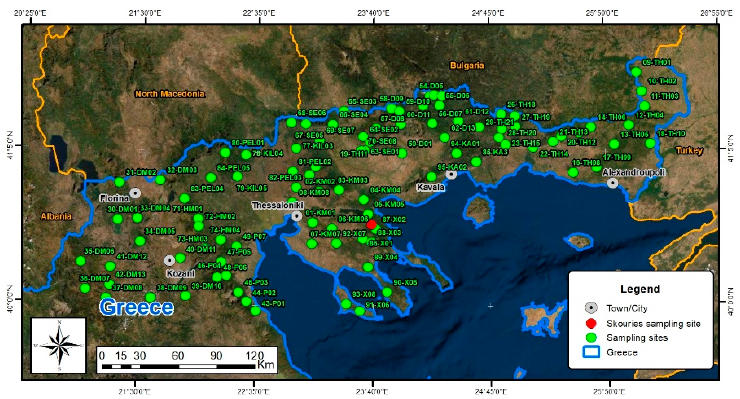
Figure 1. The moss sampling sites in Northern Greece.